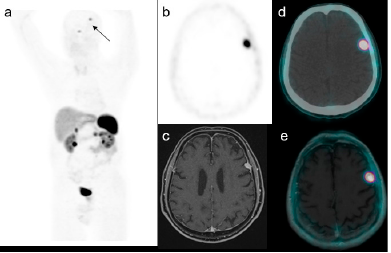
Figure 2. A representative case of a 59-year-old male with an increased uptake in the brain on the left side at maximum intensity projection (MIP, ( a )). Axial PET ( b ), MRI ( c ), PET/CT fused ( d ) and PET/MRI fused images ( e ) confirmed the presence of a focal uptake in the left frontal region with a SUVmax of 17.5 confirmed to be a meningioma.